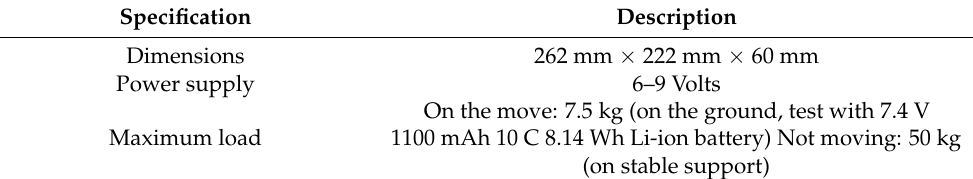
Table 6. Specifications of Multi-track chassis.